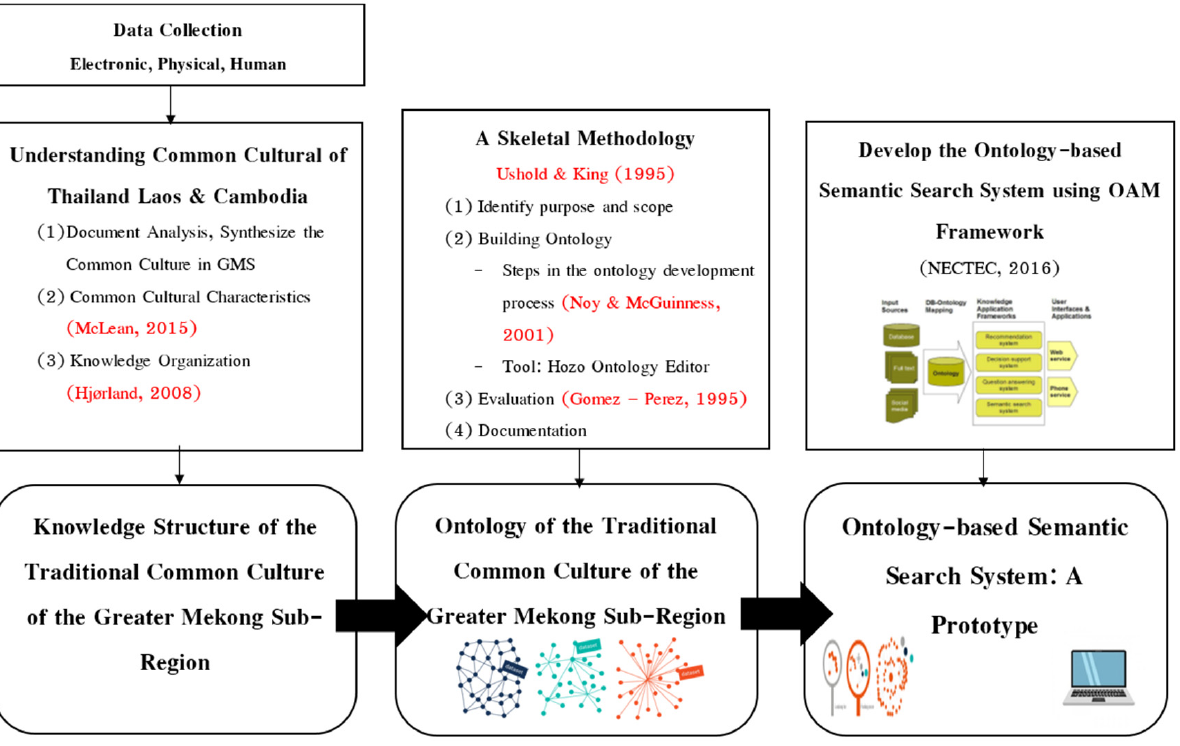
Figure 1. The research conceptual framework.